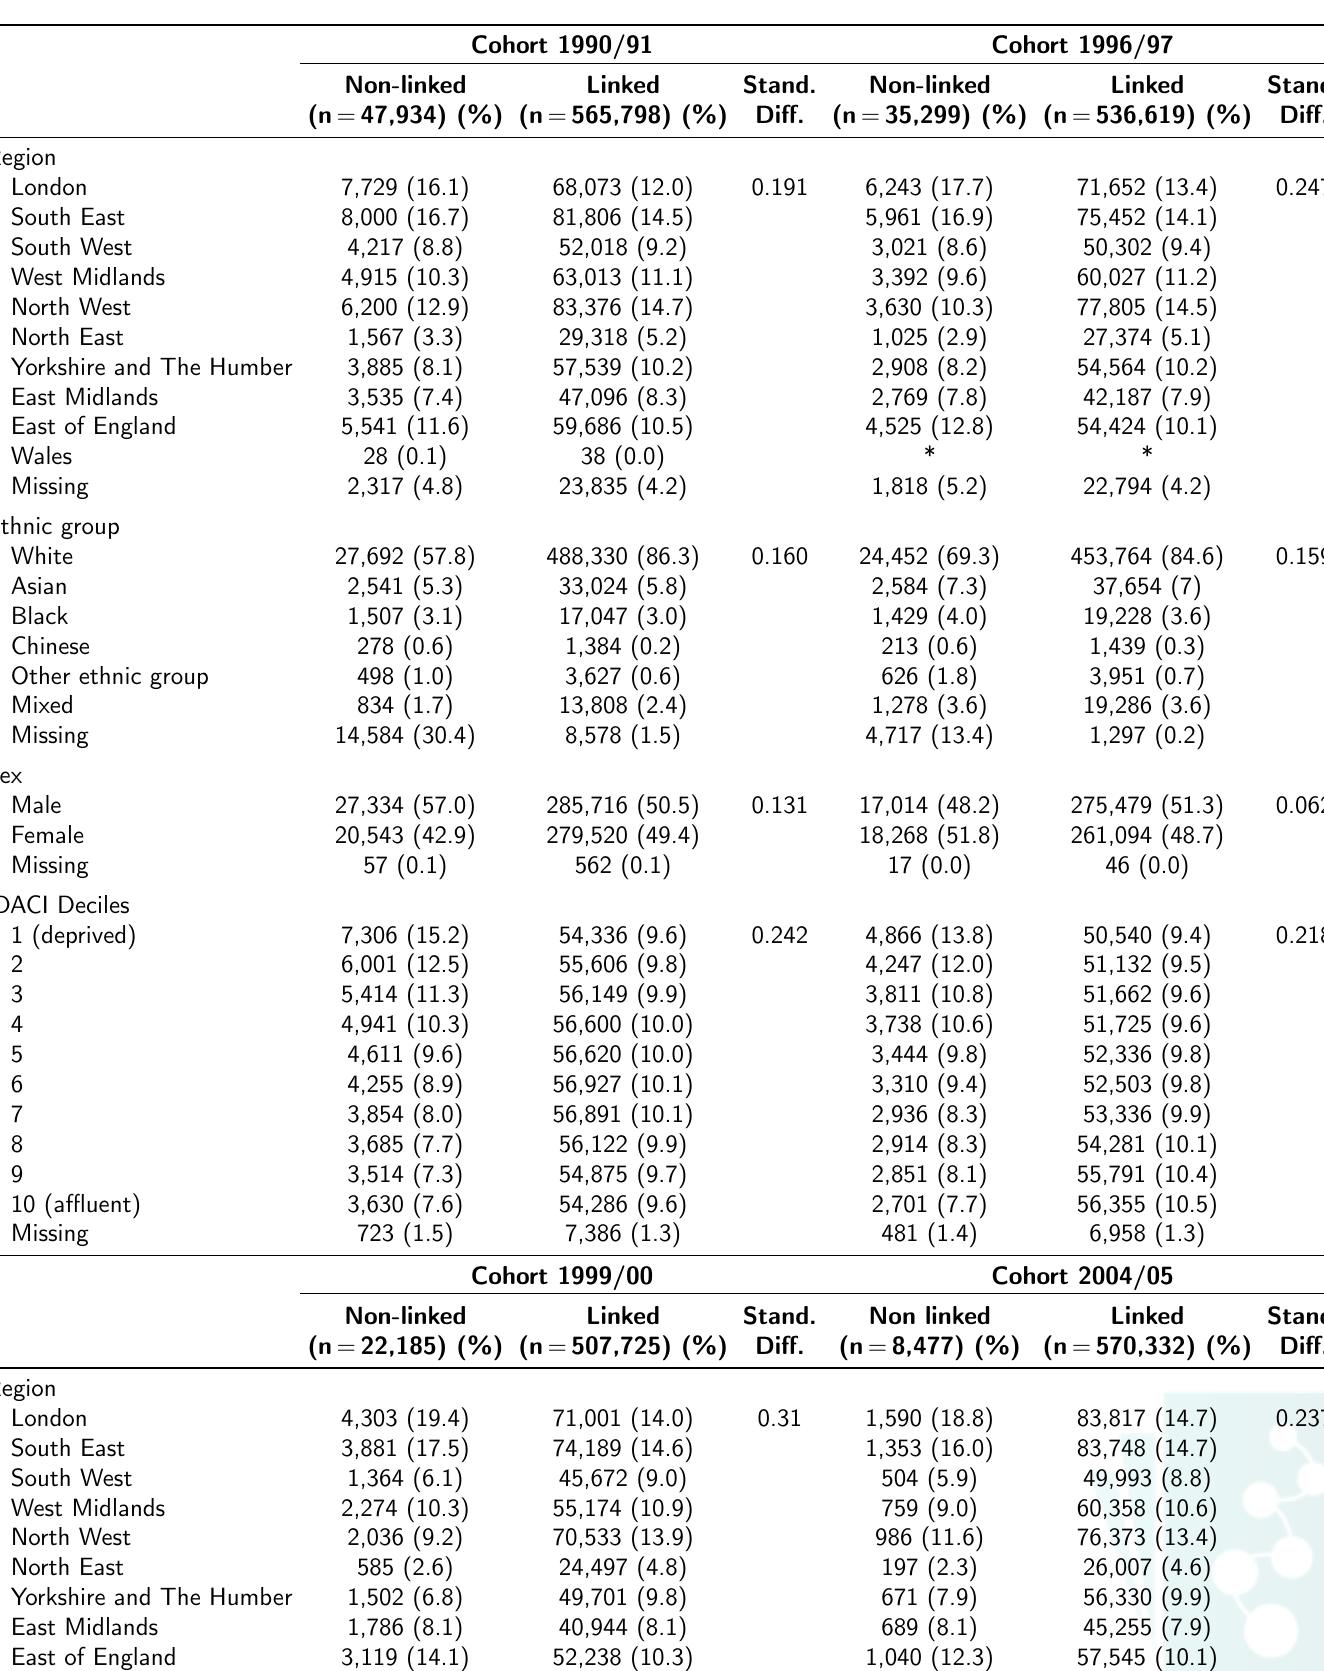
Table 4: Sociodemographic characteristics of the pupil sample from the national pupil database linked and non-linked to hospital episode statistics (N = 2,294,369 pairs). Cohort 1990/91 Cohort 1996/97 Non-linked Linked Stand. Non-linked Linked